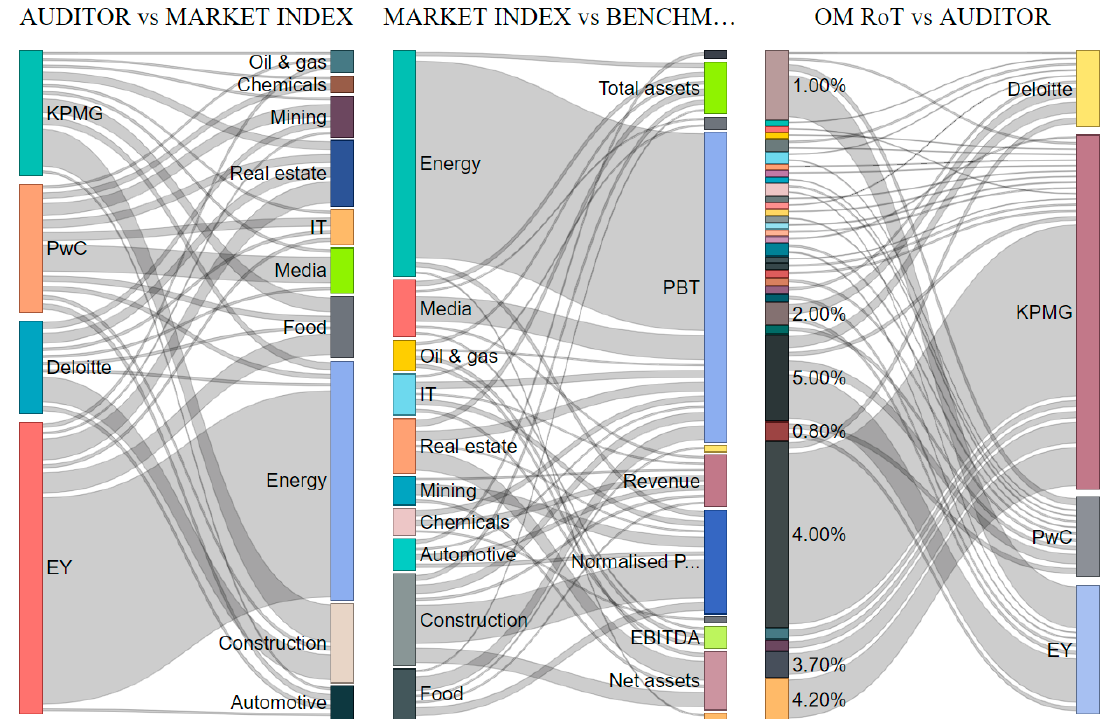
Figure 10. Relationships between auditors, benchmarks, OM RoT and WIGs—for Big 4 auditing firms. Source: own elaboration based on analyzed data.